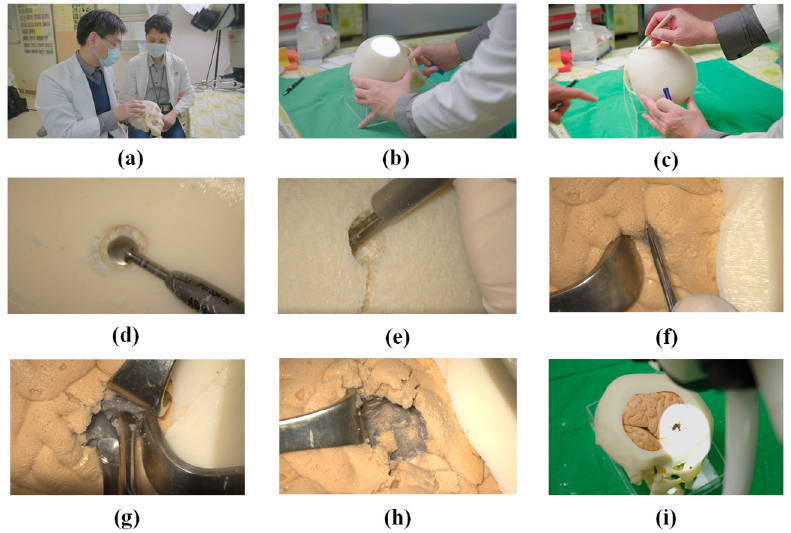
Figure 8. ( a ) Dr. Liu giving a neurosurgery trainee instructions on the use of the proposed simulator; ( b ) adjusting the angle and orientation of the head prior to commencing surgery; ( c ) marking the skull with three points to guide the trainee in sawing the top skull prior to craniotomy; ( d , e ) cutting off the top skull to expose the brain lobes; ( f ) making space between the brain lobes to locate the tumor; ( g ) using surgical forceps to remove the tumor; ( h ) removal of grey tumor tissue left a cavity within the lobe (infiltration scenario); ( i ) withdrawal of forceps and covering of skull to complete the